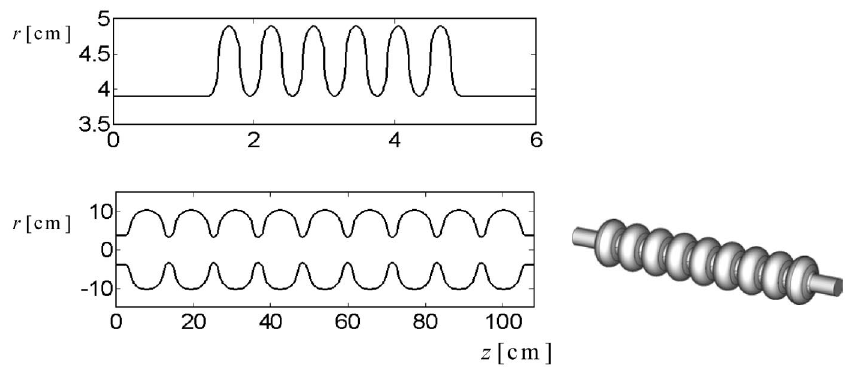
FIG. 8. The geometry of the TESLA cavity (bottom) and the bellow (top).